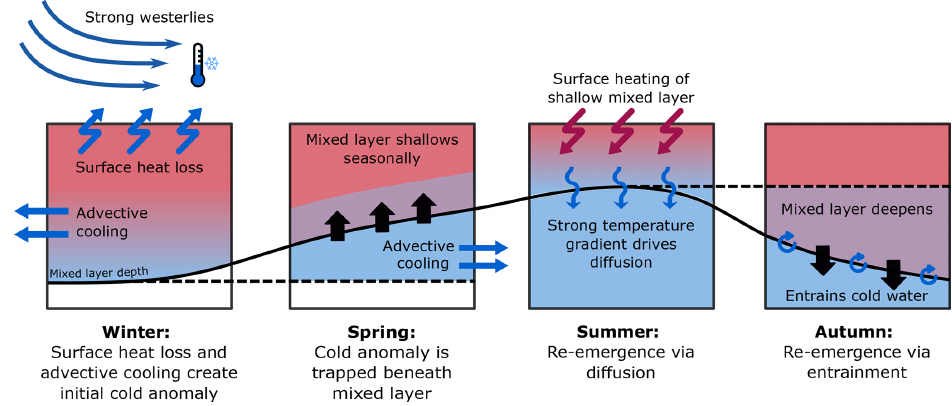
Figure 8. Schematic summarising the processes driving the re-emergence of the cold anomaly from beneath the mixed layer. The black arrows show the movement of the mixed layer and the red and blue arrows show the heat transfer. Initial surface heat loss and horizontal advection drive a cold anomaly in the deep mixed layer during winter, which is sequestered as the mixed layer shallows the following spring and summer. During summer, surface heating of the shallow mixed layer and potential advective cooling beneath the mixed layer generate a strong temperature gradient across the base of the mixed layer, resulting in strong diffusive cooling and driving the initial re-emergence of the cold anomaly. The mixed layer then deepens and cold water is entrained from beneath the mixed layer, driving further re-emergence.